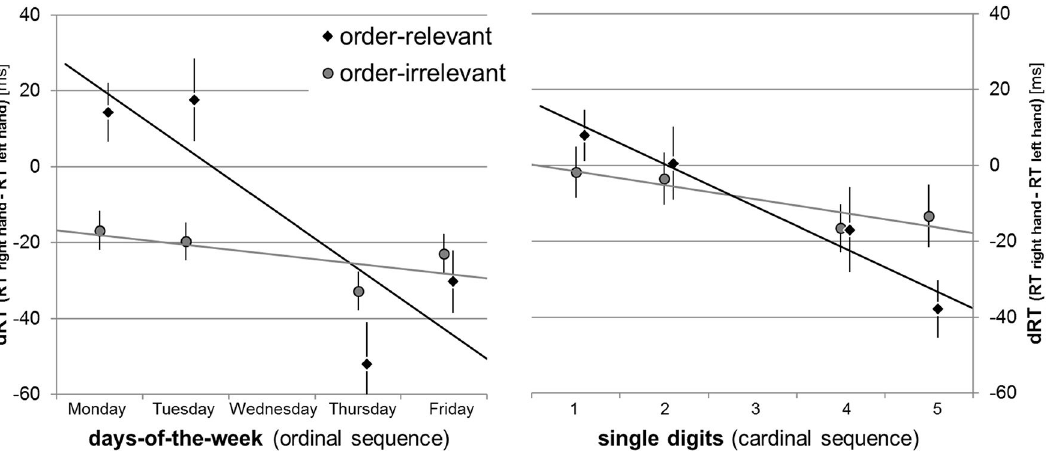
Figure 1. Right-hand over left-hand response time advantage (dRT) as a function of weekday position (left panel) and numerical magnitude (right panel) in color-judgment (gray circles and line) and comparison tasks (black squares and